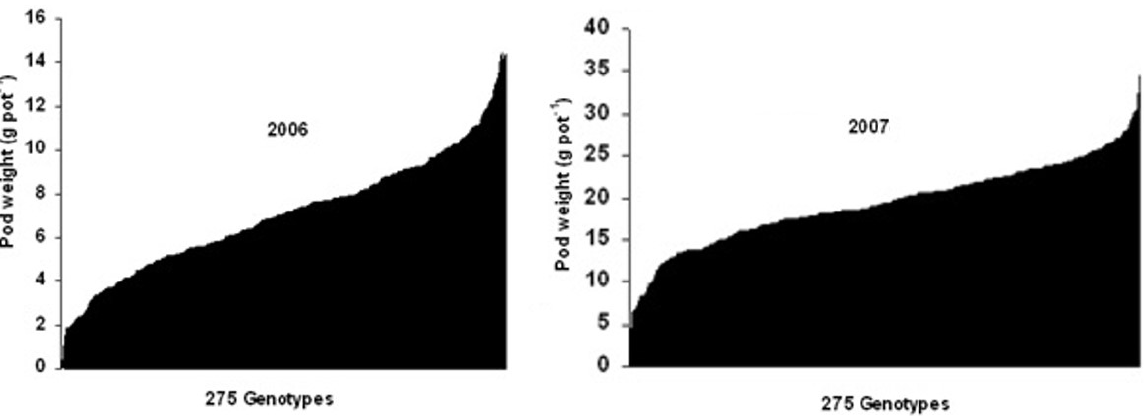
Fig. 4. The pod dry weight of 275 genotypes: Range of genotypic variation (6-7 folds) for pod dry weight under saline condition in 2006 and 2006-2007; Data are means (n = 3) of 275